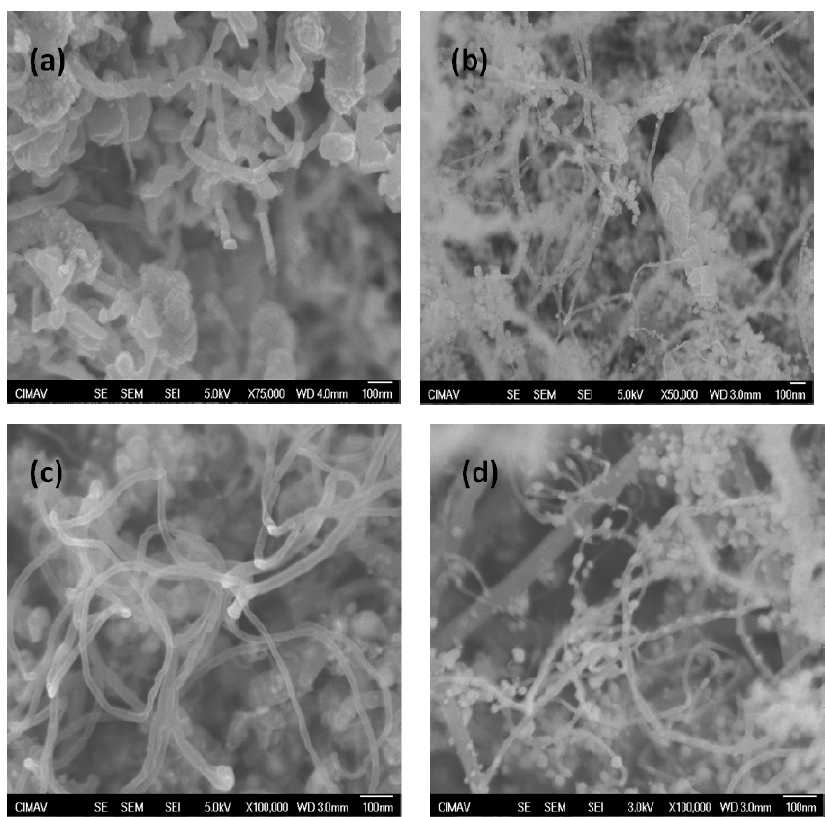
Figure 2. SEM images of carbon nanotubes obtained with the different carbon sources: ( a ) Methanol; ( b ) Ethanol; ( c ) Propanol and ( d )